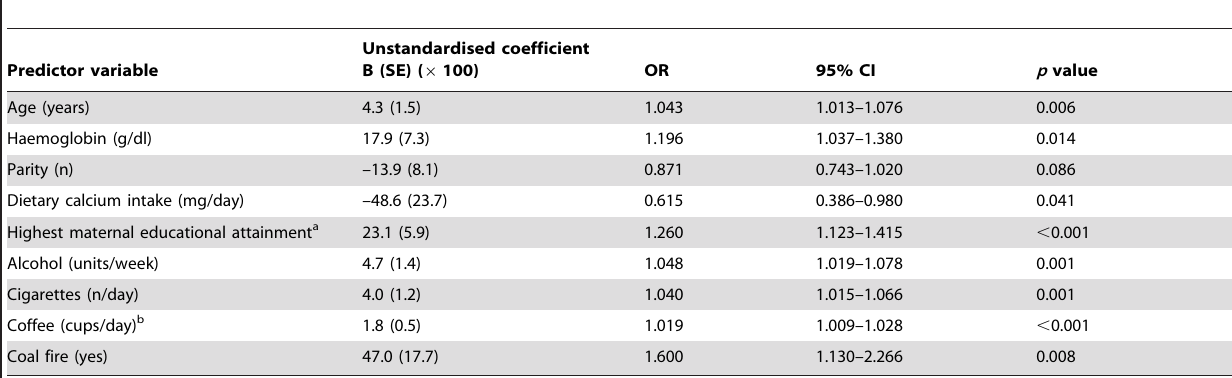
Table 3. Regression coefficients for potential variables that remained after backward stepwise logistic regression to predict maternal BLL , 5 or $ 5 m